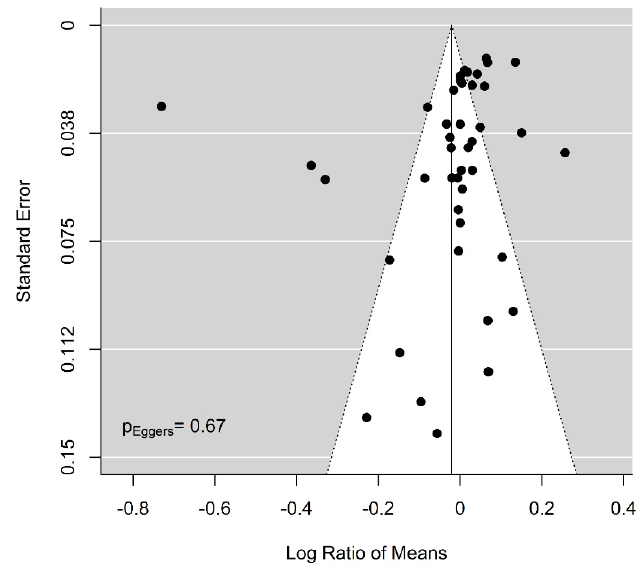
Figure A14. Funnel plot for methyl donors and fetal/birth weight in all studies. The funnel plot and Eggers regression do not indicate publication bias in studies reporting the effect of methyl donor supplementation on fetal or birth weight. Dots are the included studies.